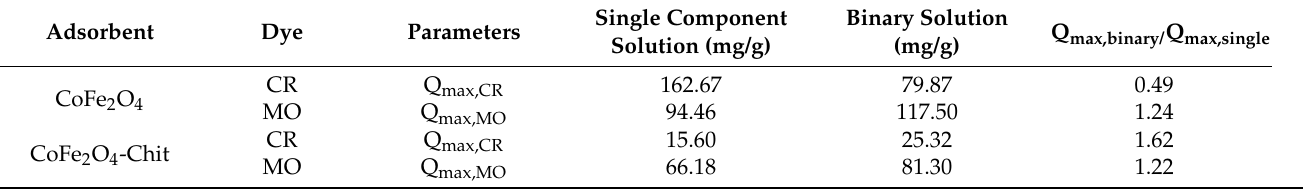
Table 2. Maximum adsorption capacity calculated using Langmuir and modified Langmuir isotherm models for single- component and binary solutions.